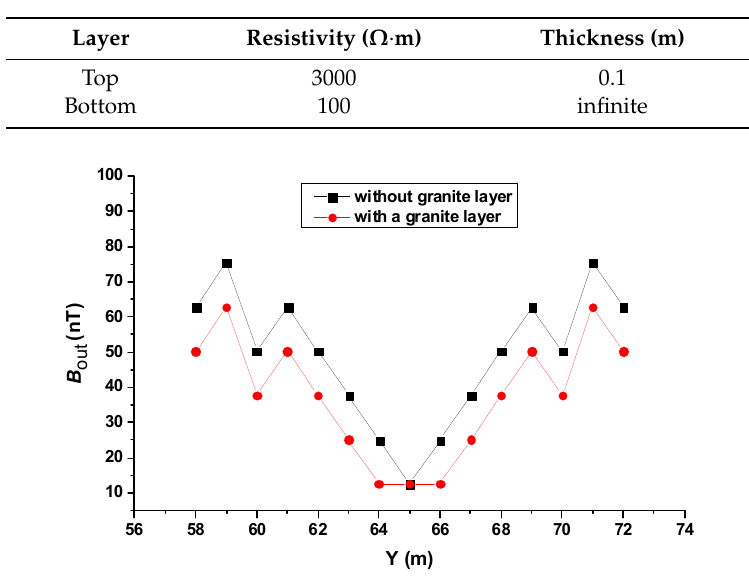
Figure 14. The secondary field intensity along the survey line above the #6 conductor with and a high resistivity layer without a high resistivity layer present.